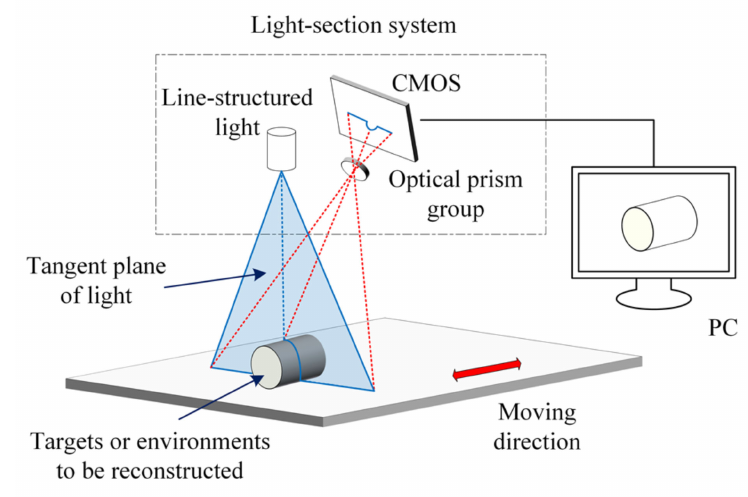
Figure 2. Diagram of the light-section reconstruction system.